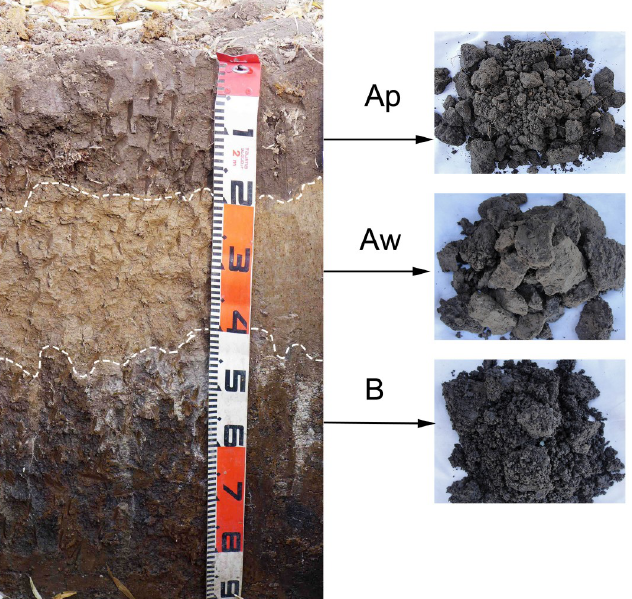
Fig 1. Typical Albic soil at State Farm 853, Heilongjiang China. Ap: topsoil (0–20 cm), Aw: Albic soil layer (20–40 cm); B: illuvial soil layer (40–60 cm).